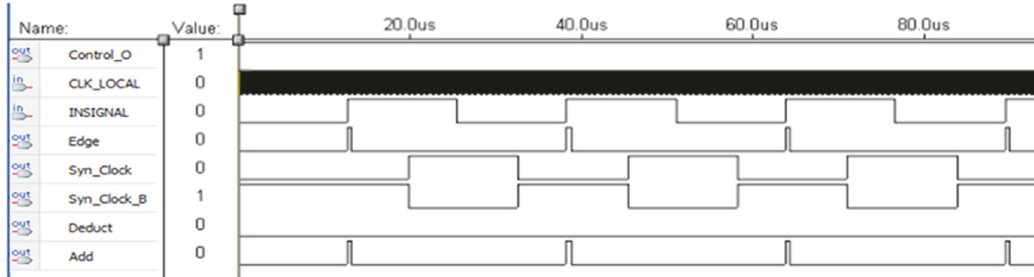
Figure 5: Simulation result of differential phase detector in phase